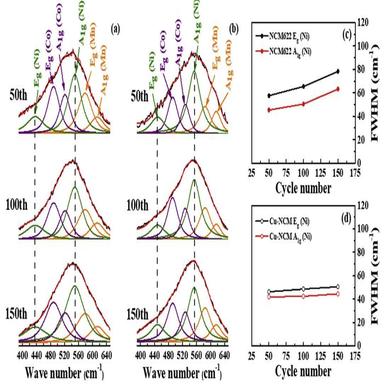
Raman spectrums of NCM622 (a) and Cu-NCM (b) electrodes under different cycles (50th, 100th, 150th). The FWHM values of the two main modes of vibration of Ni in the NCM622 (c) and Cu-NCM (d) electrodes after different cycles.